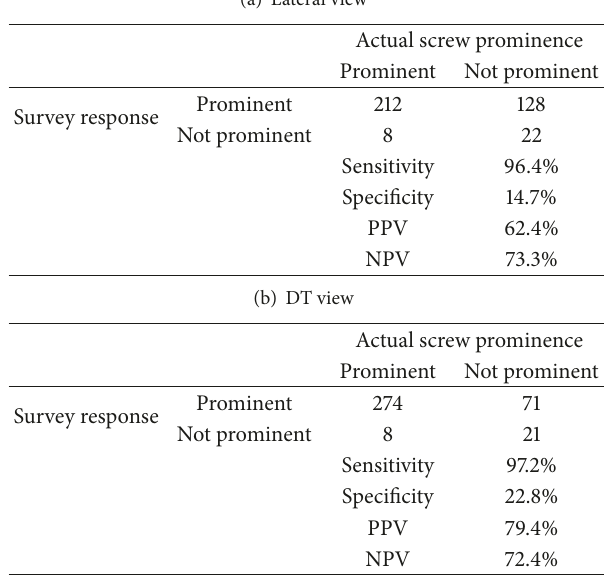
Table 2: Composite sensitivity and specificity of the lateral and DT